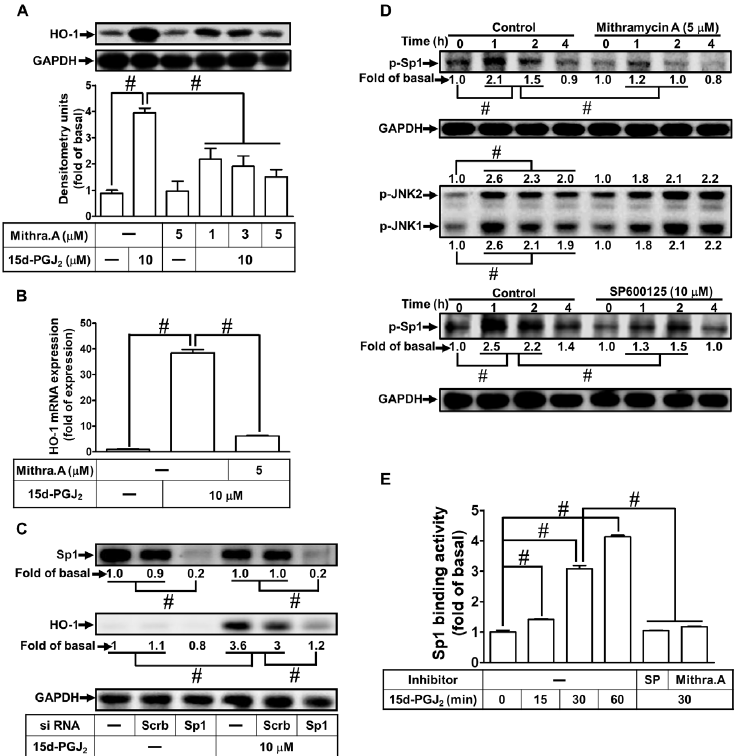
Figure 5. Involvement of transcription factor Sp1 in HO-1 expression stimulated by 15d-PGJ 2 in bEnd.3 cells. ( A ) The cells were preprocessed with Mithramycin A (1, 3, and 5 μM) for 1 h and then challenged with 15d-PGJ 2 (10 μM) for 6 h. The HO-1 protein expression was determined by Western blot with GAPDH as an internal control. ( B ) Mithramycin A (5 μM) pretreated the bEnd.3 cells for 1 h, which were challenged with 15d-PGJ 2 (10 μM) for 4 h. The mRNA expression of HO-1 was analyzed by real-time PCR. ( C ) The bEnd.3 cells were transfected with scrambled or Sp1 siRNA and then challenged with 15d-PGJ 2 (10 μM) for 4 h. The levels of HO-1 and Sp1 protein expression were determined by Western blot with GAPDH as an internal control. ( D ) bEnd.3 cells were preprocessed with Mithramycin A (5 μM) or SP600125 (10 μM) for 1 h and then administrated with 15d-PGJ 2 (10 μM) for 1, 2, and 4 h. The phosphorylation levels of Sp1 and JNK1/2 were determined by Western blot with GAPDH as an internal control. ( E ) bEnd.3 cells were stimulated with 15d-PGJ 2 for 15, 30, and 60 min alone or 30 min while cells were pretreated with Mithramycin A (5 μM) or SP600125 (10 μM) for 1 h. The binding of Sp1 to the promoter region of HO-1 was determined with a ChIP assay. Data are expressed as the mean ± S.E.M. of three independent experiments. # p < 0.01, as compared with the basal level or treatment with 15d-PGJ 2 alone. Abbreviations: Mithra. A: Mithramycin A; SP: SP600125; Sp1: specificity protein 1.